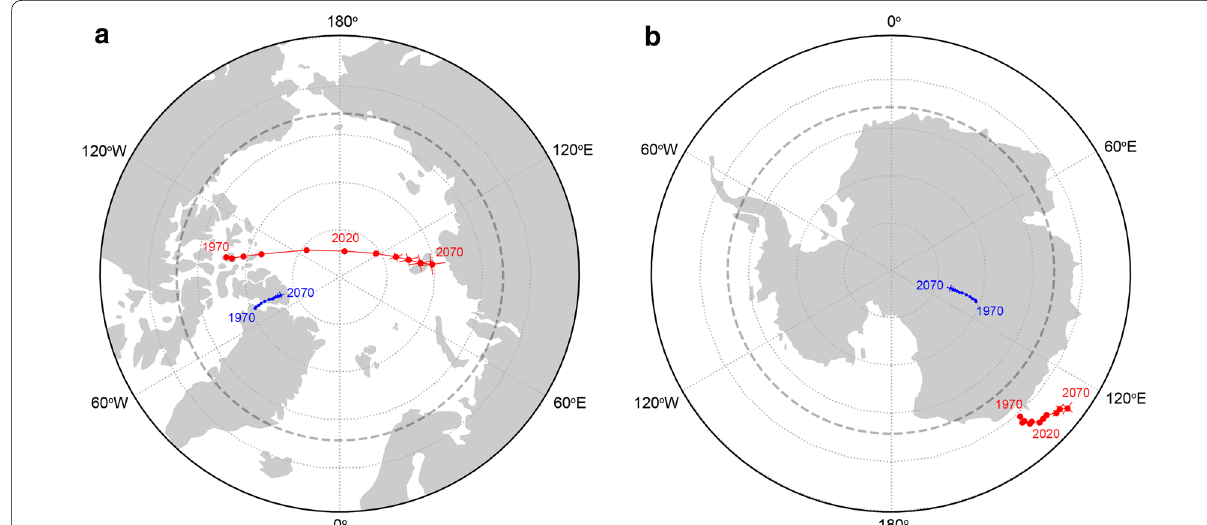
Fig. 11 Evolution of the geomagnetic poles (blue) and magnetic dip poles (red) over the period 1970–2070, evaluated every 10 years (note that after 2020 only the forecast is shown, while before only the analyses are displayed). The magnetic dip poles where calculated using the field at the native truncation of the dynamo model ( ℓ = 85